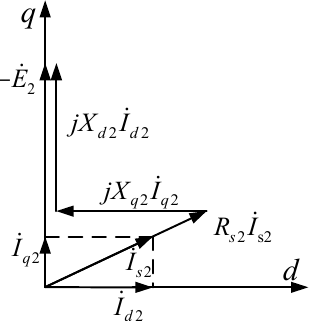
Figure 5. Phasor diagram of LLSM with three-phase short-circuit fault.